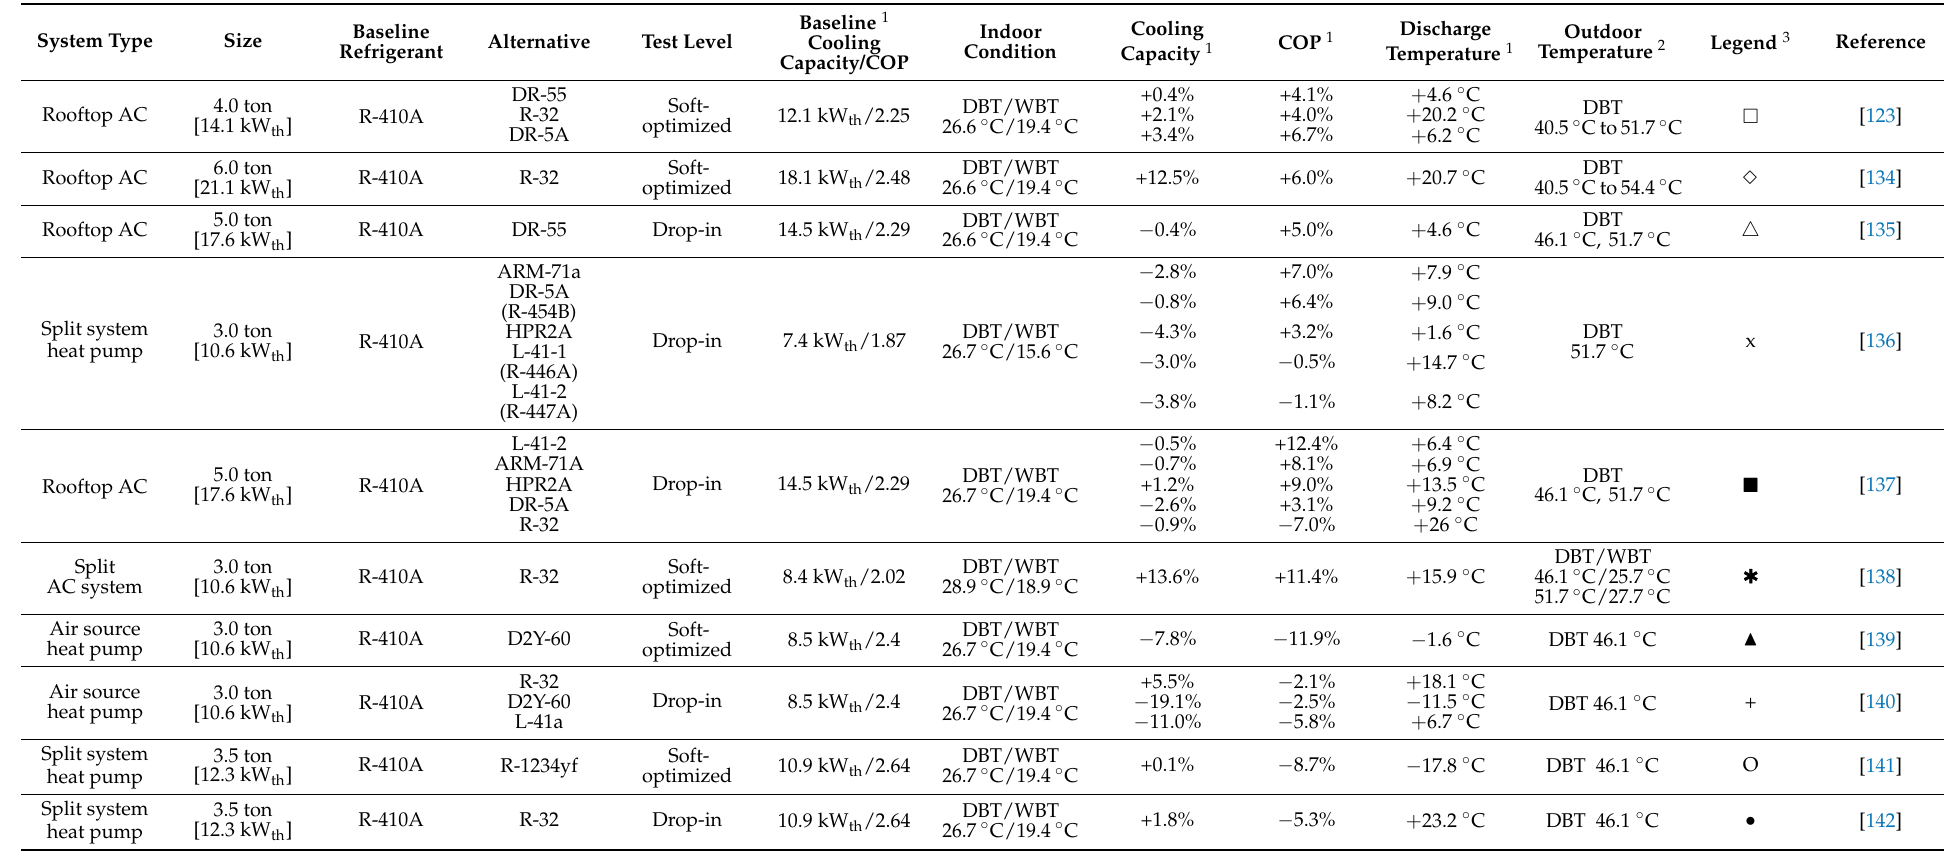
Table 11. AHRI Low-GWP AREP results for R-410A alternative refrigerants at HAT conditions.